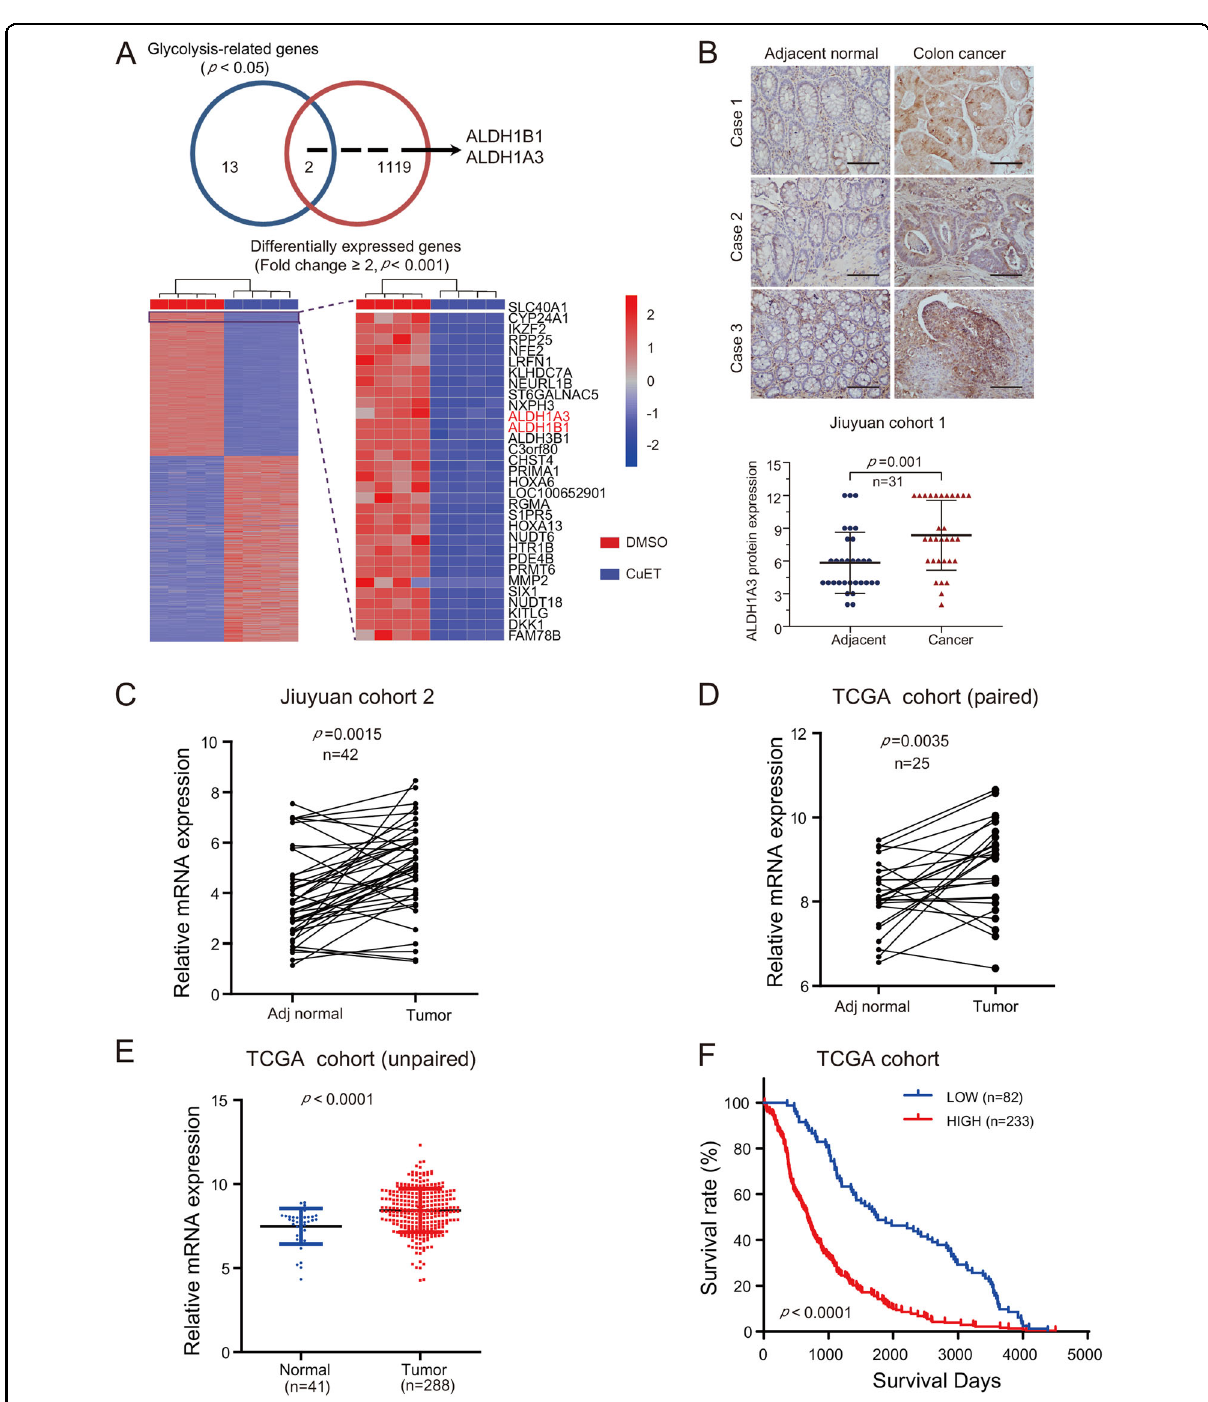
Fig. 3 ALDH1A3 is the potential target gene of CuET and is correlated with prognosis. a Overlap of differentially expressed genes regulated by CuET and glycolysis enzymes. Heatmap revealing the differentially expressed genes in four replicates of the control- and CuET-24h treated HCT116 cells. Each row represents the relative level of expression of a single gene in all samples. The red and blue blocks represent up- and down-regulated genes, respectively, relative to the control cells. b Expression of ALDH1A3 in colorectal cancer tissues and paired normal tissues using IHC analysis. n = 31. Scale bars, 100 mm (top panel). ALDH1A3 protein expression was shown in the lower panel. c RT-qPCR showed that ALDH1A3 mRNA expression was upregulated in CRC compared to paired adjacent normal tissues in Jiuyuan cohort 2. d , e RNA-seq data from the TCGA study also showed that ALDH1A3 expression was up-regulated in CRC compared with adjacent normal tissues (paired ( d ) and unpaired ( e ) samples). f Prognostic value of ALDH1A3 expression was analyzed in CRC patients from TCGA